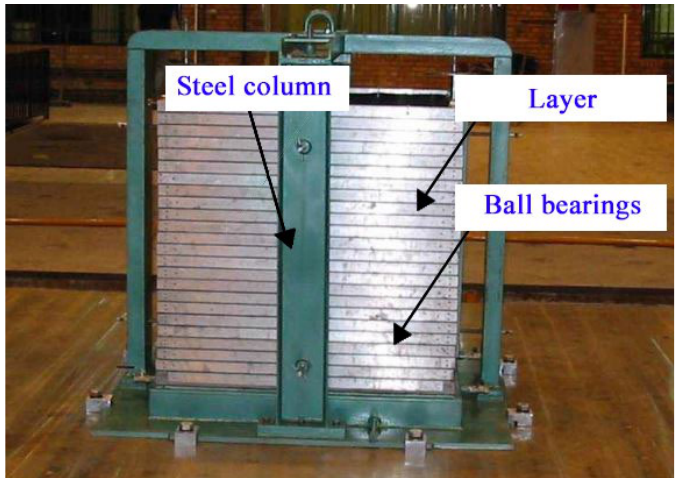
Figure 13. General view of the laminar container (From Jafarzadeh [30]; modified).